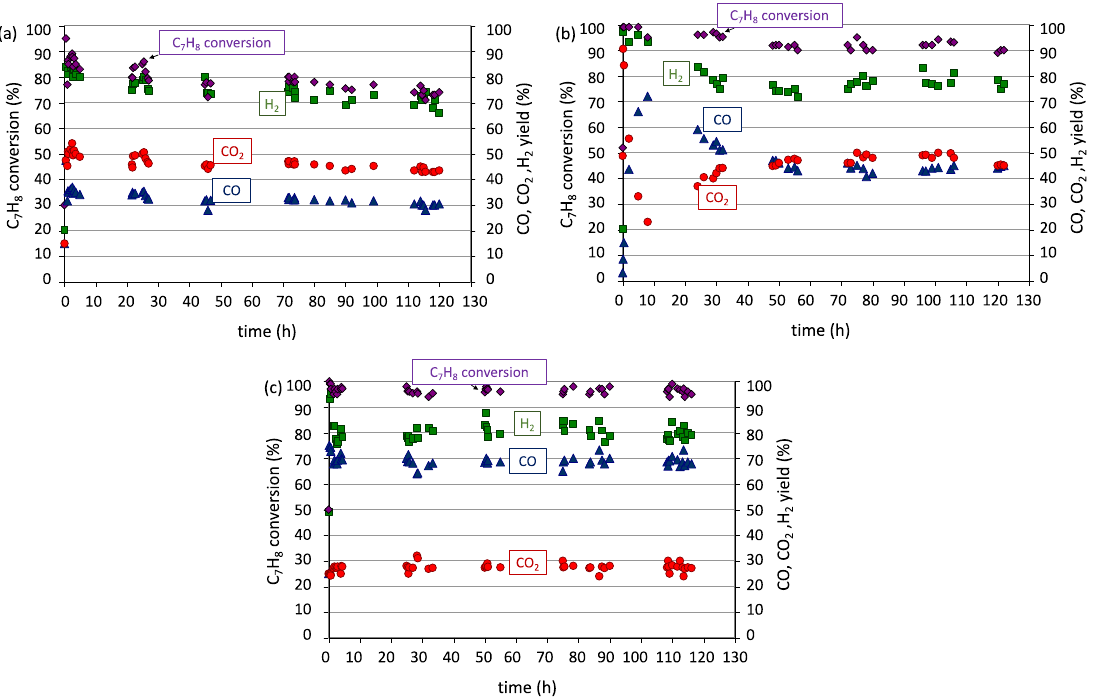
Figure 11. The toluene conversion and products’ (CO, CO 2 , H 2 ) yields during stability tests of toluene steam reforming over Ni/CeZrO 2 carried out at S/C = 2.4 and t c = 0.36 s at 600 °C ( a ), 700 °C ( b ), and 800 °C ( c ). Table 6. The weight loss of Ni/CeZrO 2 samples and the rate of carbon deposition after stability tests of toluene steam reforming carried out S/C = 2.4 and t c = 0.36